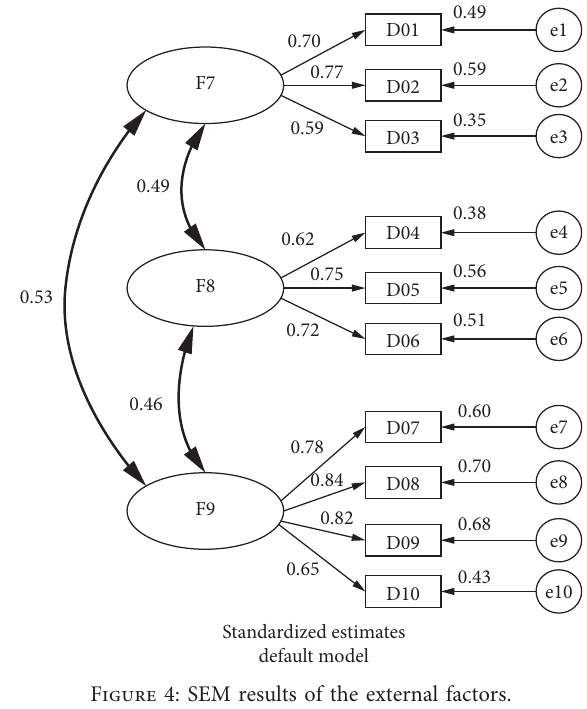
Figure 4: SEM results of the external factors.